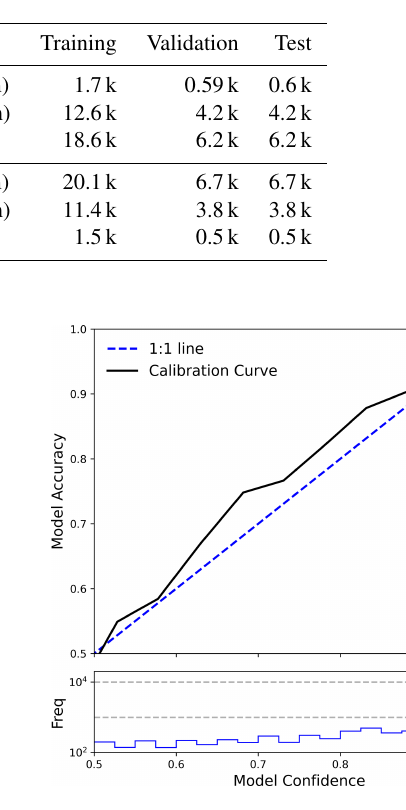
Figure 5. UWILD confidence is plotted against UWILD accuracy with a black solid line (this is referred to as the calibration curve) in the top row, and a histogram of model confidence is shown in the bottom row on a shared x axis. This analysis is done on the test set. The proximity between the calibration curve and the one-to-one blue dashed line implies that UWILD confidence can be used as a proxy for the uncertainty in UWILD’s